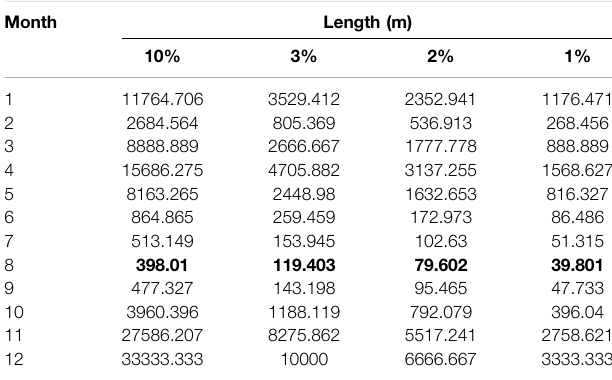
TABLE 4 | Length to the rainwater harvesting system considering variation in the percentage of demand for fresh